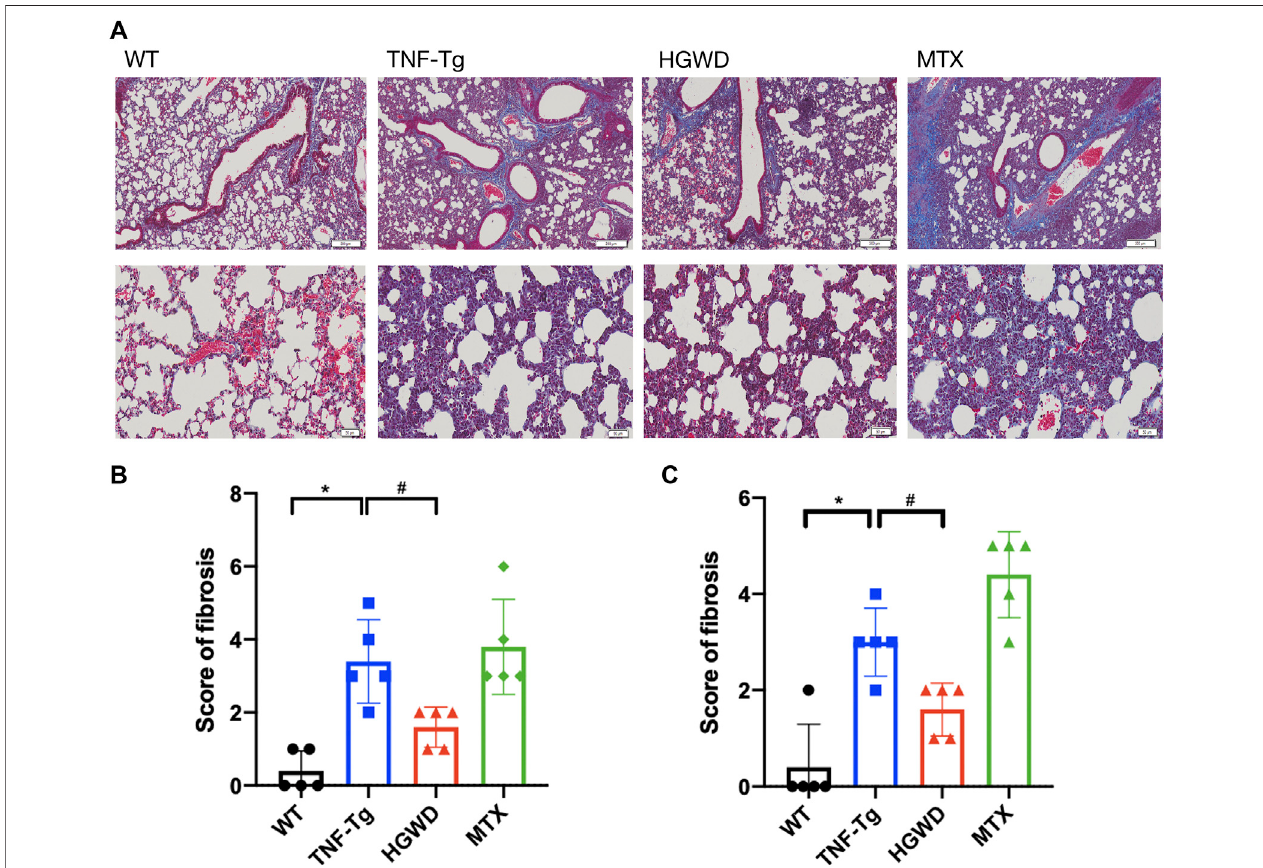
FIGURE7 | HGWD reduces lung fi brosisin TNF-Tgmice. (A) TNF-Tg mice have obvious fi brosis near the lung bronchus,and the fi brotic tissueisblue. The areaof lung fi brosisinthemicetreatedwithHGWDisreduced,andthelung fi brosisinthemicetreatedwithMTXisaggravated.Bar=200 μ morBar=50 μ m. (B) Quanti fi cation of pulmonary peri bronchial fi brosis score. (C) Quanti fi cation of alveolar fi brosis score. Values are the mean plus or minus SD of 5 lungs in each group. * p < 0.05, compared with WT group; # p < 0.05, compared with TNF-Tg